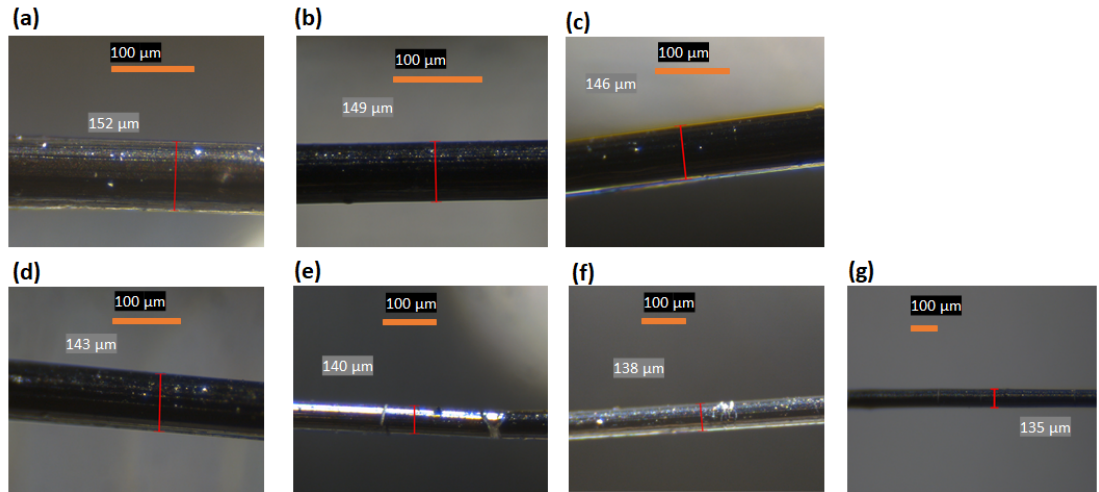
Figure 3. Images of LLDPE/MP fibres taken using a Nikon ECLIPSE ME600 optical microscope: ( a ) LLDPE 30 wt%, ( b ) LLDPE 40 wt%, ( c ) LLDPE 50 wt%, ( d ) LLDPE 60 wt%, ( e ) LLDPE 70 wt%, ( f ) LLDPE 80 wt%, and ( g ) LLDPE 90